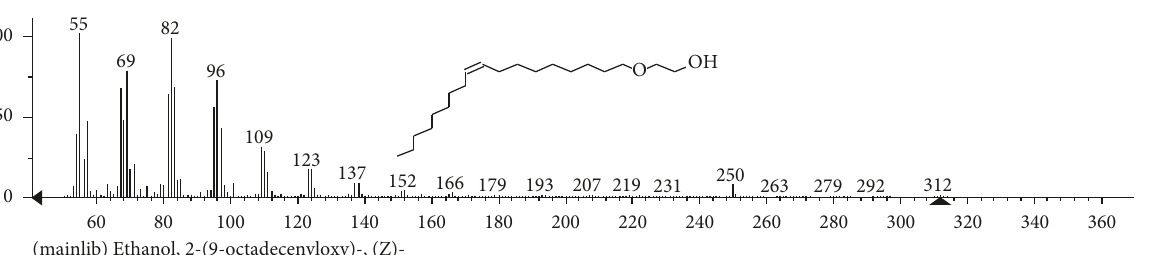
Figure 66: Mass spectrum of compound ethanol, 2-(9-octadecenyloxy)-, (Z)- of whole plant hexane fraction of Achillea wilhelmsii (WHFAW).